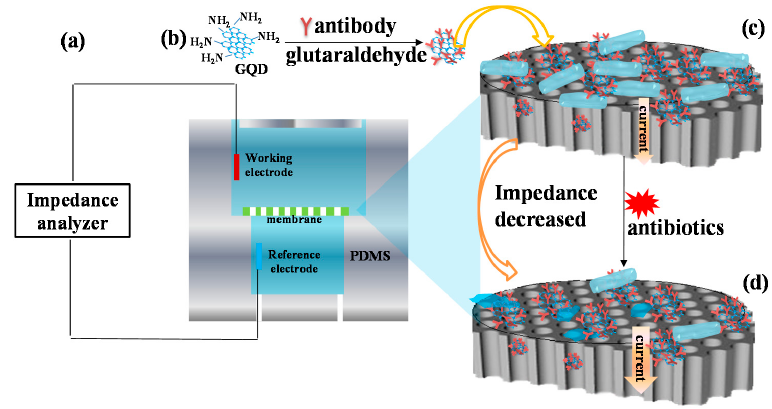
Figure 1. The schematic diagram of nanoporous membrane and GQD-based biosensor for Salmonella bacteria response to antibiotics detection.